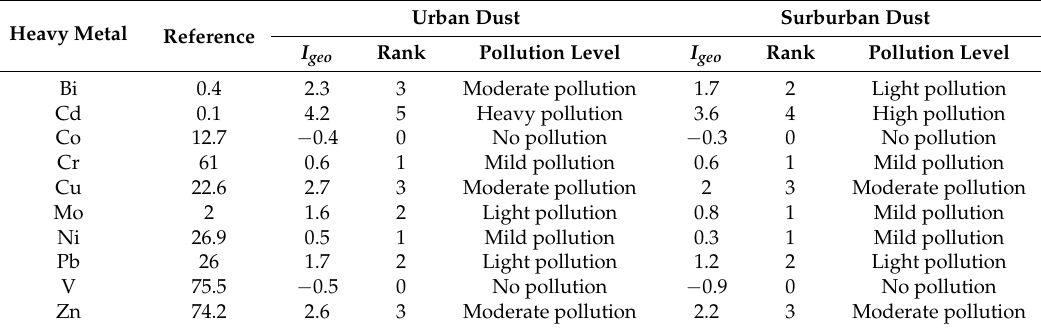
Table 6. The geo-accumulation index of dust heavy metals during winter in